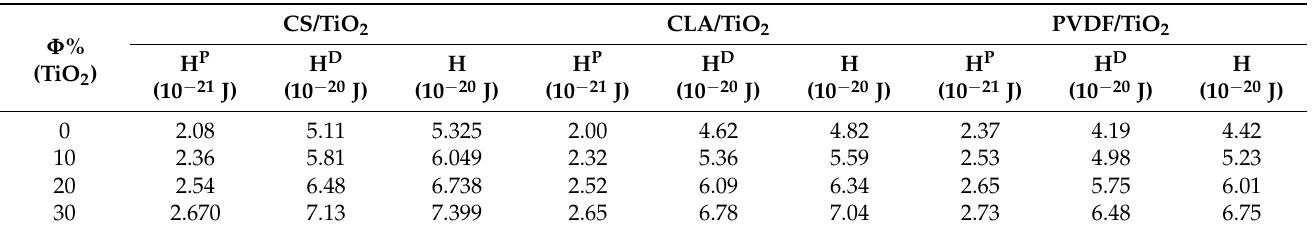
Table 4. Hamaker constants of CS/TiO 2 , CLA/TiO 2 and PVDF/TiO 2 nanocomposites as function of volume fraction of TiO 2 NPs.